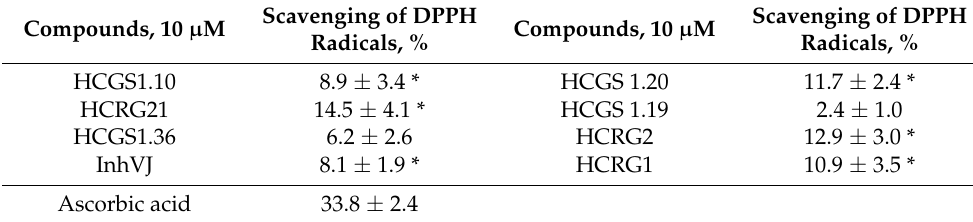
Table 3. DPPH radical scavenging activity of Kunitz-type